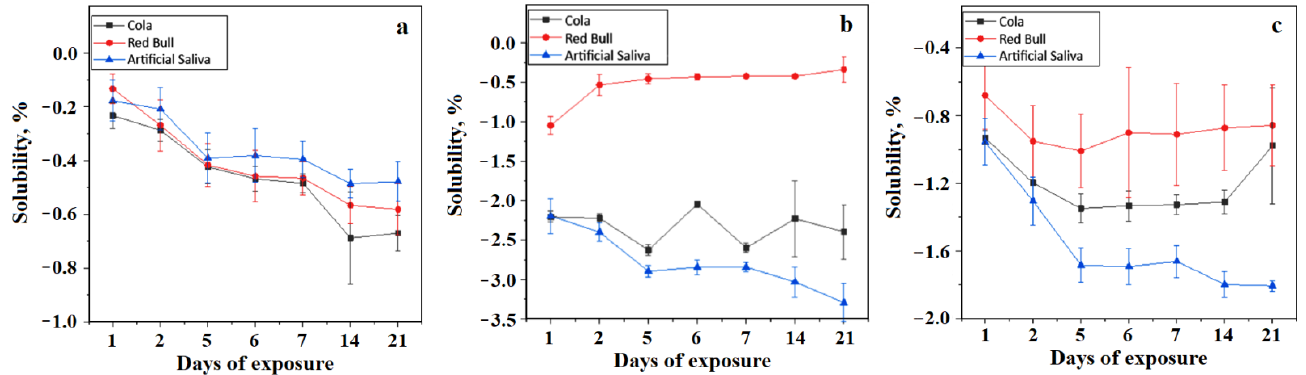
Figure 3. Solubility curve results for the tested orthodontic cements: ( a ) BracePaste, ( b ) Fuji Ortho, and ( c ) Transbond.